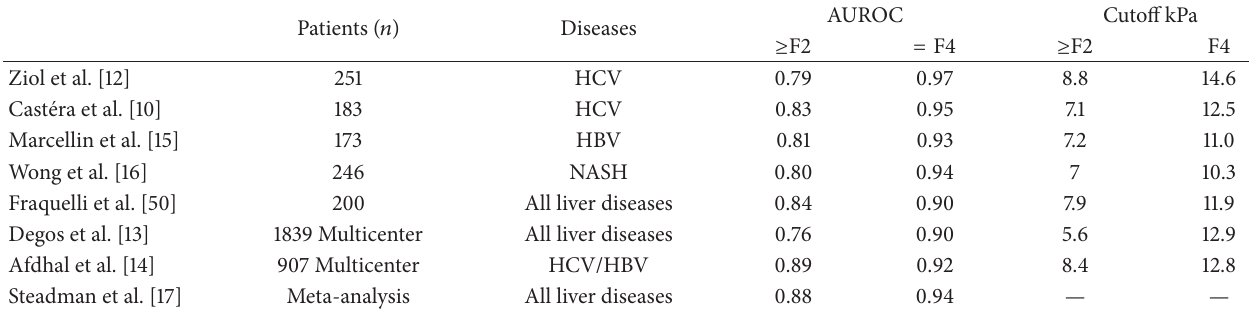
Table 2: Diagnostic use of Transient Elastography in